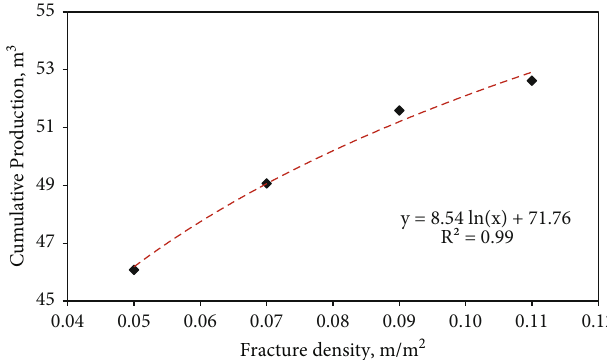
Figure 5: Relation equation between fracture density and 200-day cumulative production.